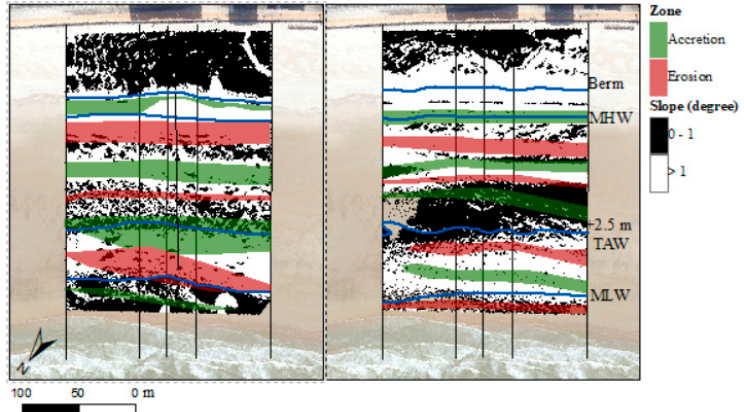
Figure 10. Beach slope (left = November, right = April) with zones of maximum erosion / accretion indicated for days when considerable o ff shore (left) or onshore (right) suspended sediment transport was measured by the